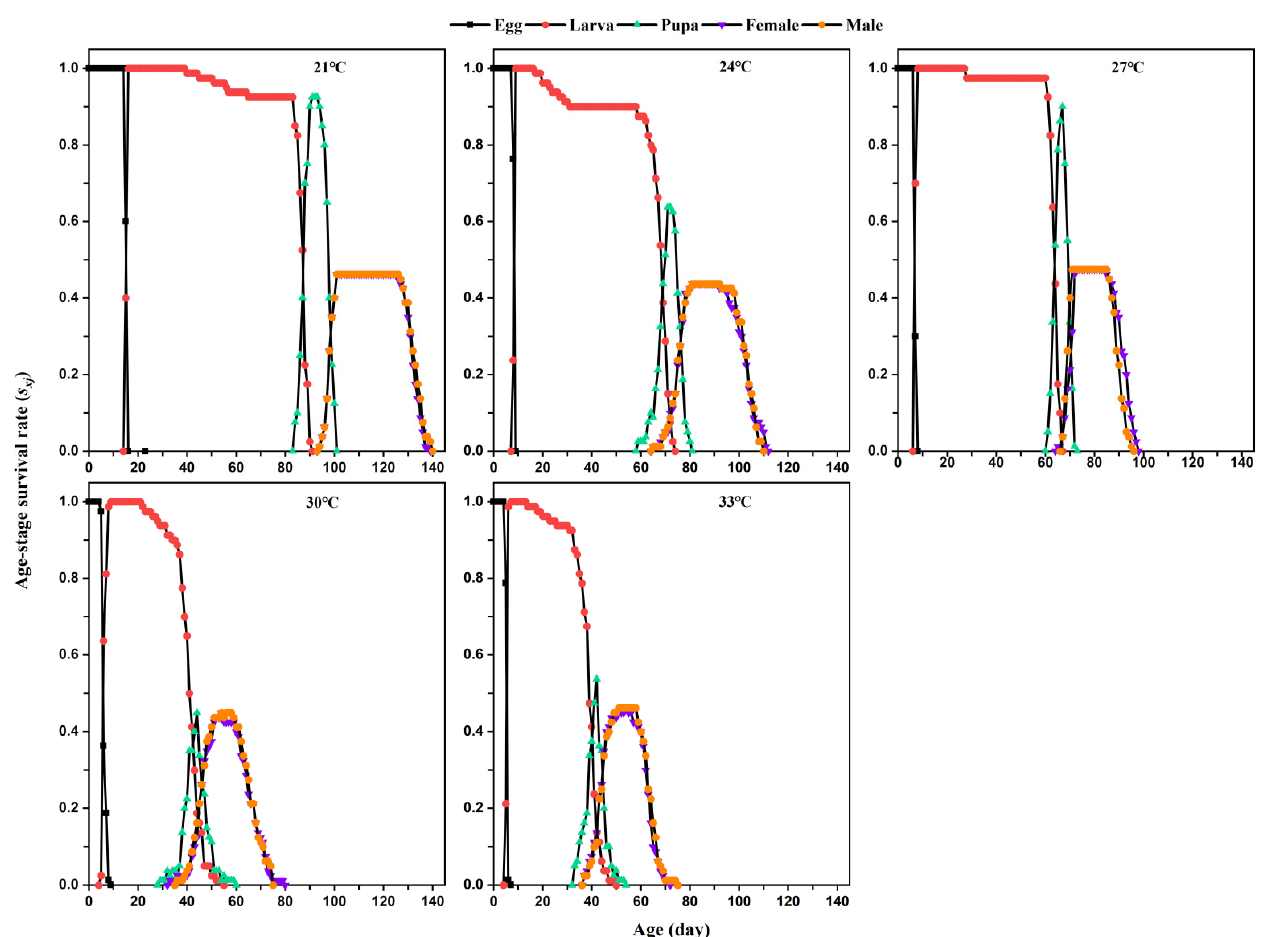
Figure 1. Age-stage-specific survival rates ( S xj ) of L. serricorne at different temperatures.